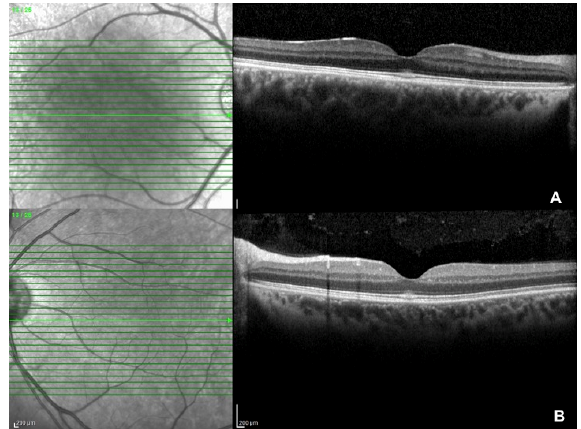
Figure 1: OCT demonstrates hyperreflectivity and irregularity of the ellipsoid zone at the fovea; A) OD, B) OS Best-corrected visual acuity was 0.9 and intraocular pressure was 16 mmHg in both eyes. Anterior segment was unremarkable. Fundus examination revealed hyper- reflective appearence at macula with a faint foveolar reflex. OCT (Spectralis ® , Heidelberg Engineering Inc., Heidelberg, Germany) demonstrated focal hyperreflectivity and irregularity of the ellipsoid zone at the fovea (Figure 1A,B). No other retinal abnormalities were found. FOF (short wavelength autofluorescence imaging, Heidel- berg Spectralis) was normal (Figure 2A,B). OCTA (Avanti RT Vue XR ® with AngioVue ® software; Optovue